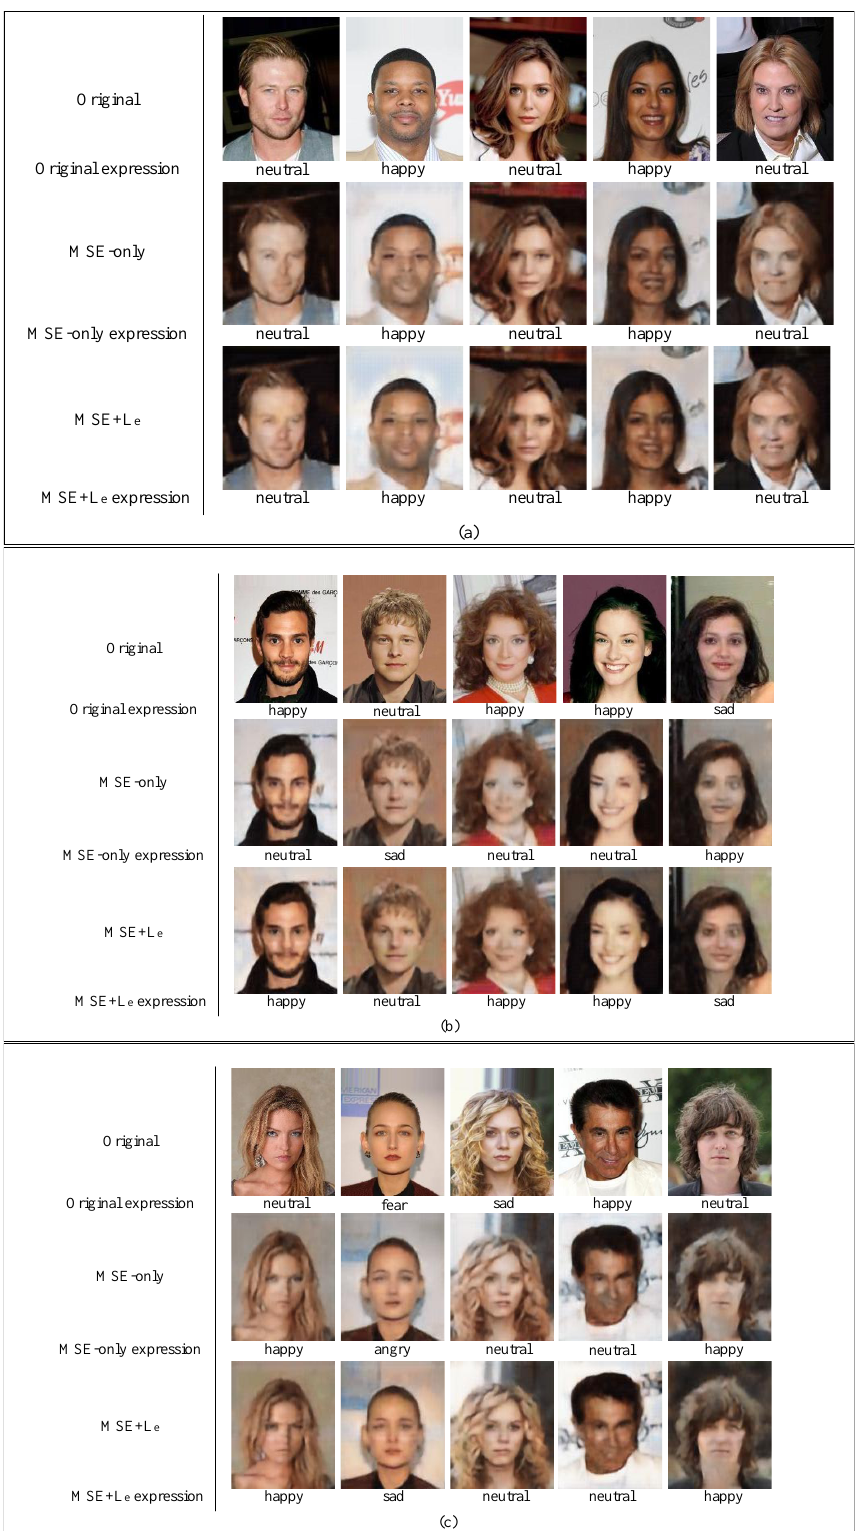
Figure 7. The result of service quality maintenance ( a ) Image utility was maintained without expres- sion loss. ( b ) Image utility was maintained only after expression loss was added. ( c ) Image utility was damaged even after adding expression